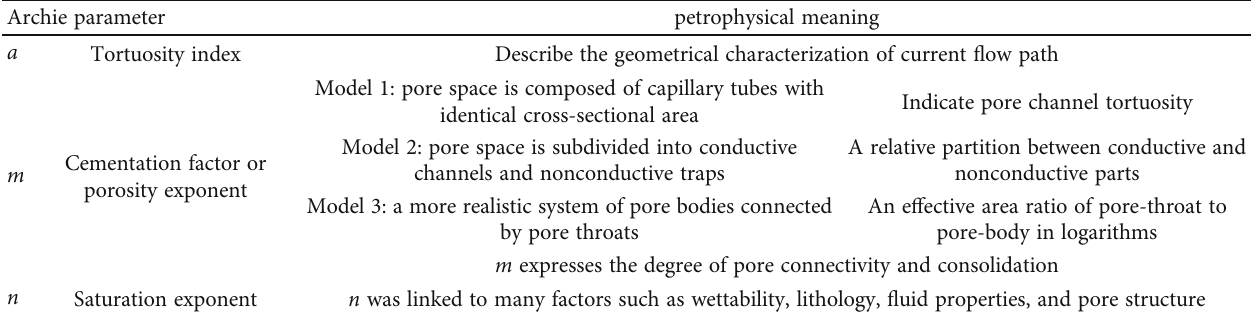
Table 1: The petrophysical meaning of Archie parameters.